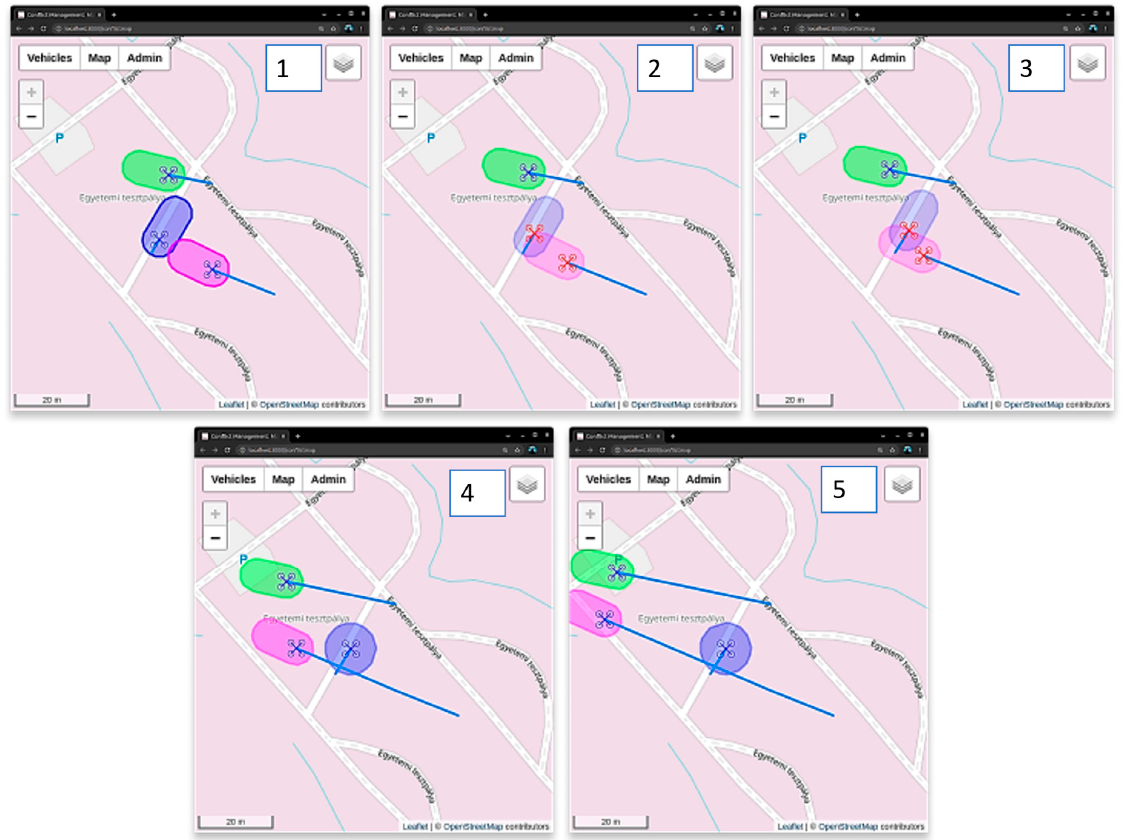
Figure 7. Multi-vehicle conflict resolution 1 , 2 : Conflict is detected between blue and purple, 3rd vehicle (green) unaffected; 3 : Lower priority (blue) vehicle is given command to stop and moves out of impact path; 4 , 5 : Conflict is resolved, vehicles not stopped carry on, commanded (blue) continues mission after safety delay. Non-English text are road section designa- tions.